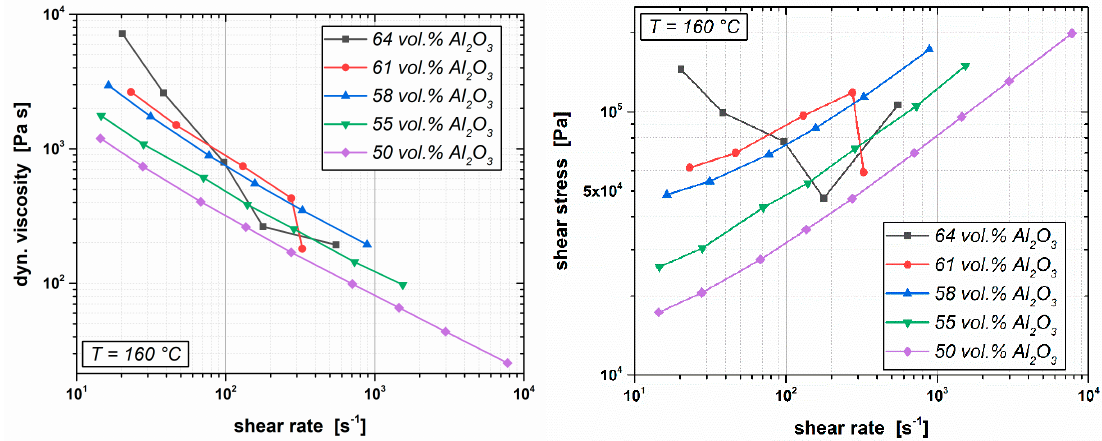
Figure 5. Rheological characterization of polyvinyl butyral- (PVB-) / polyethylene gycol (PEG)-based molding compounds with filler degrees of alumina powder between 50 vol.% and 64 vol.%.